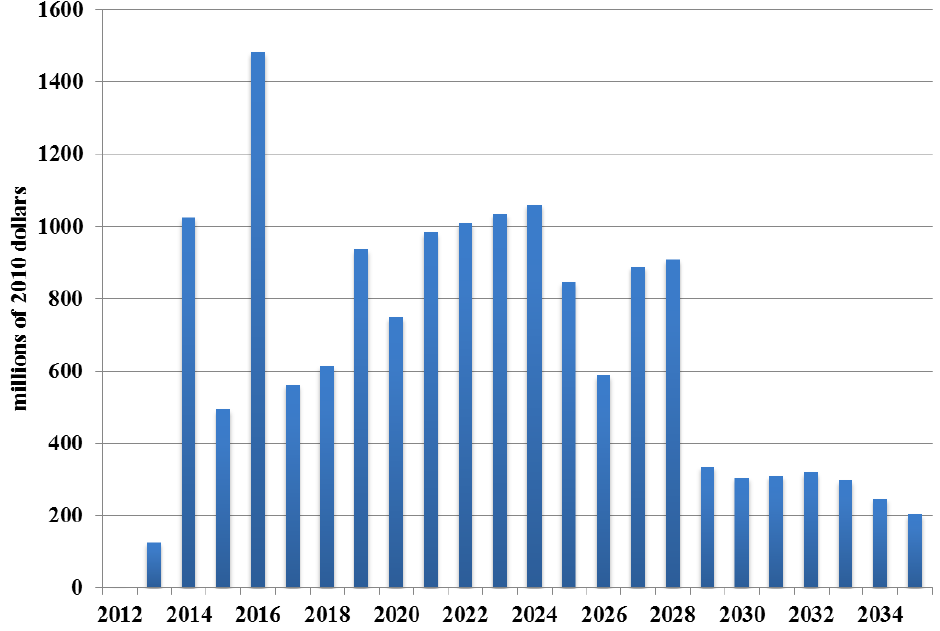
Figure 5. Total expenditures for new crude oil production from Santa Barbara